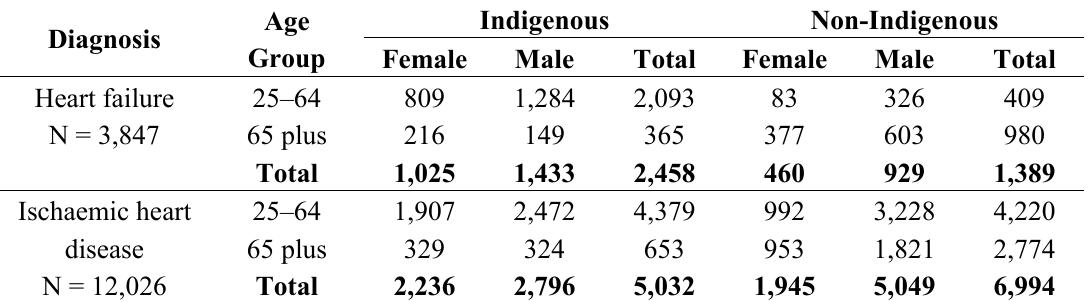
Table 2. Number of admissions for each diagnosis grouping for 1992–2011, all